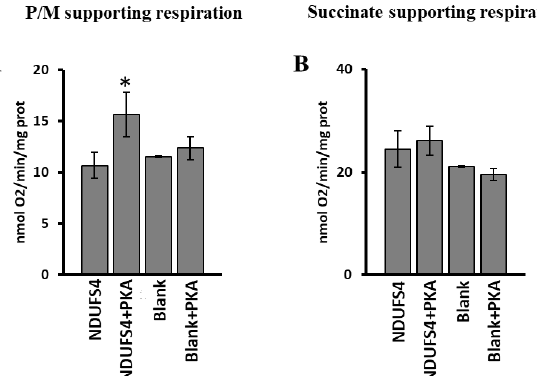
Figure 8. PKA addition to mitochondrial import experiments increased the complex I-supporting respiration. RRL translation mixtures containing newly synthesized [ 35 S]-Met-labeled NDUFS4 protein or no protein present (Blank) were added to the import mixture containing RLM in absence and in the presence of PKA. After 60 min incubation at 30 °C, mitochondria were spun down from the import mixture and used to measure the oxygen consumption rates. ( A ) Oxygen consumption rates using pyruvate/malate (P/M) as substrate. ( B ) Oxygen consumption rates using succinate as substrate. The values are the means ± SD of three different experiments. (NDUFS4 + PKA vs. NDUFS4, * p < 0.05, Student’s t -test). For more details, see under Materials and Methods.